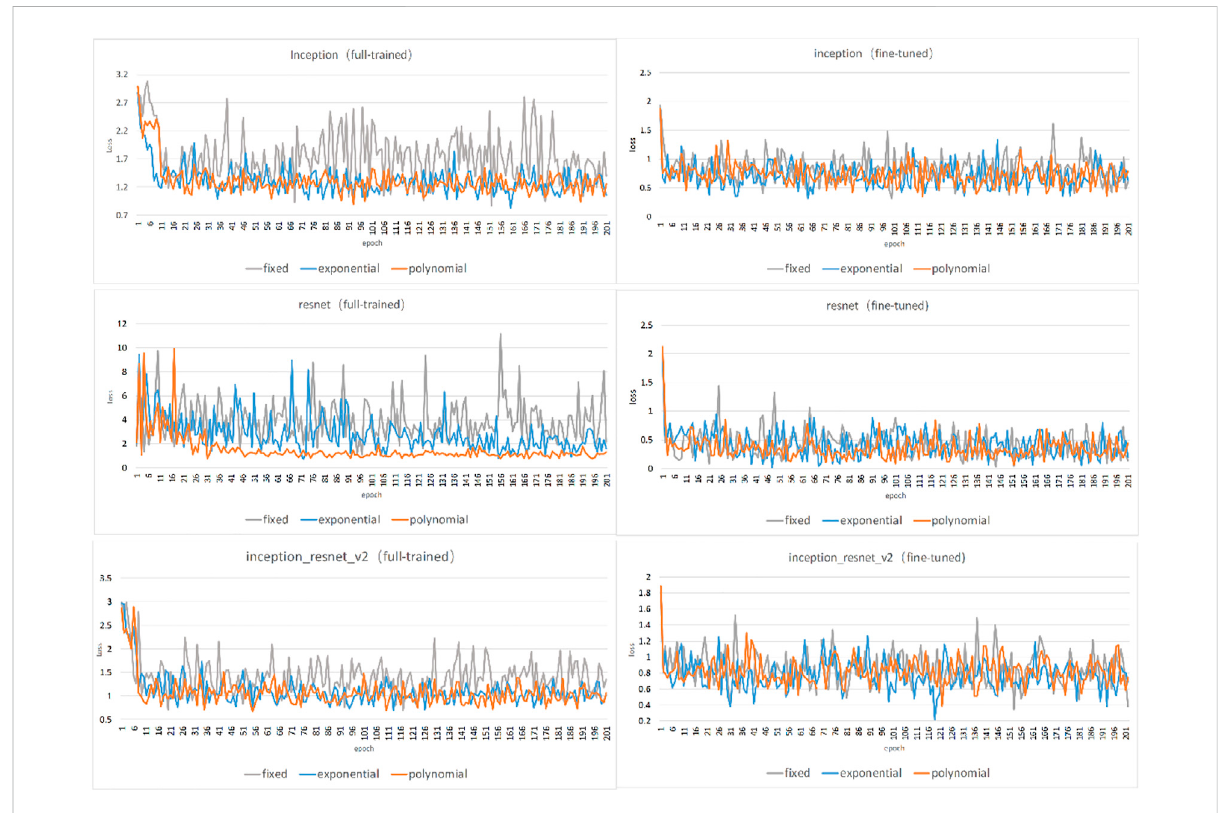
FIGURE 8 Loss values of different training strategies and CNNs.